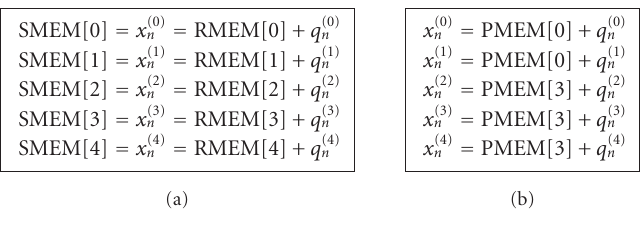
Figure 5: Memory operations in sample step, (a) for implementation with two memories and (b)for implementation with one memory. particles will be stored in the memory SMEM at